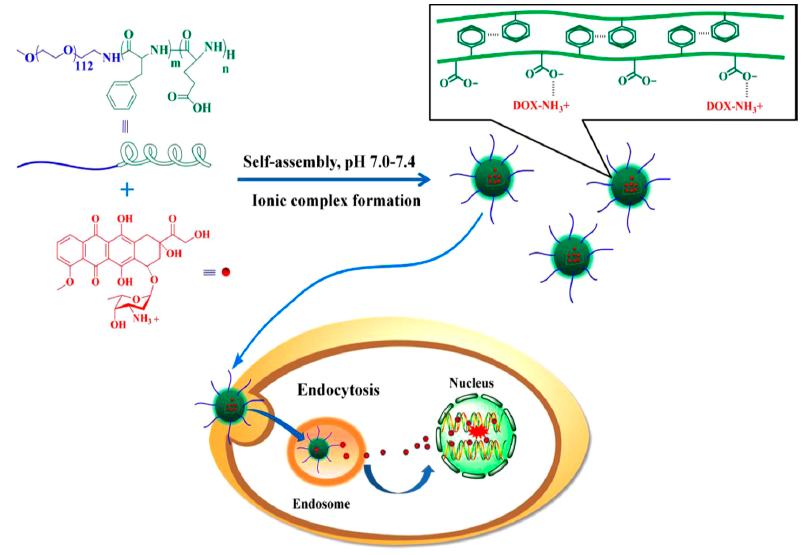
Figure 5. Preparation and interaction mechanism of doxorubicin (DOX)-nanoparticles with cancer cells. Reference 21.